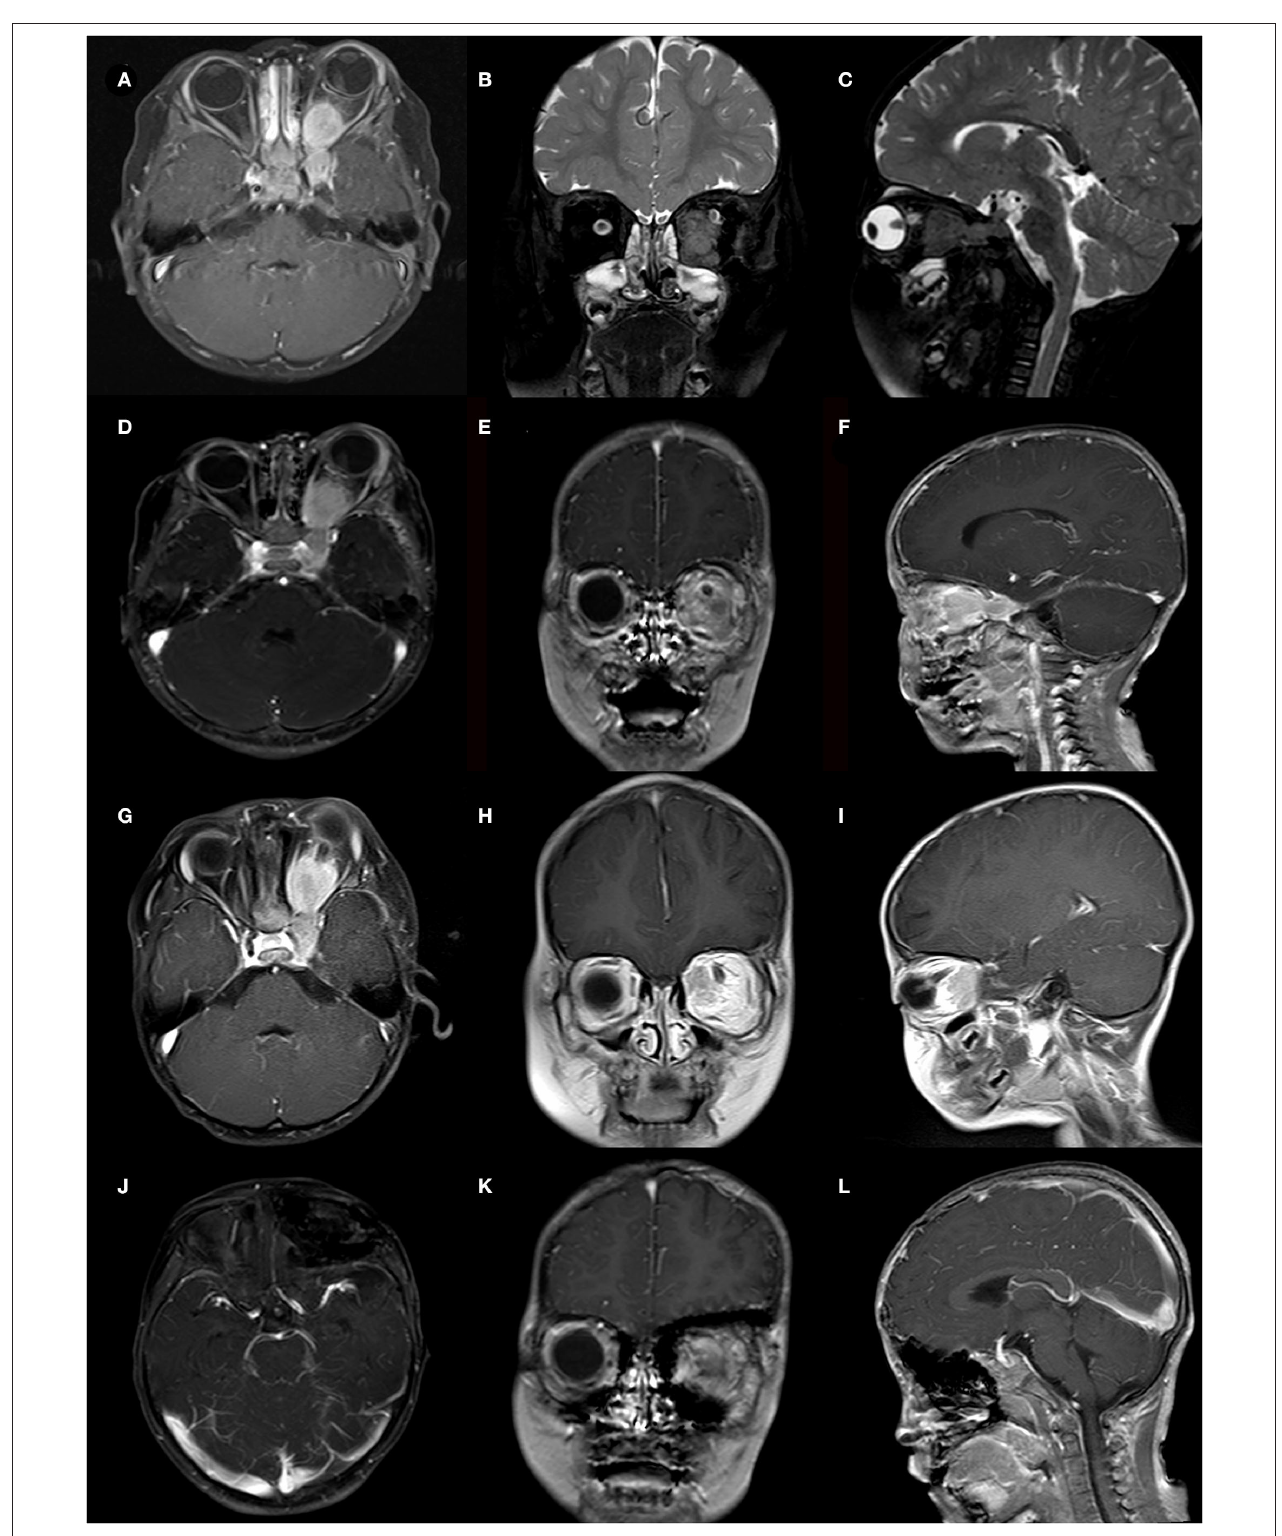
FIGURE 2 | A case of 2-year-old boy presented with a cranial-orbital lesion. (A–C) Preoperative MRI showed a left dumbbell-shaped lesion with invasion of extraocular muscles and cavernous sinus. (D–F) STR was conducted to remove lesions about 1 cm * 1cm from the orbital apex, and pathological biopsy reveals a WHO-grade-I meningioma. (G–I) MRI follow-up at 12 months showed tumor progression and the second surgery was taken. (J–L) MRI follow-up at 18 months after the second surgery showed no tumor recurrence but the patient suffered severe visual failures.